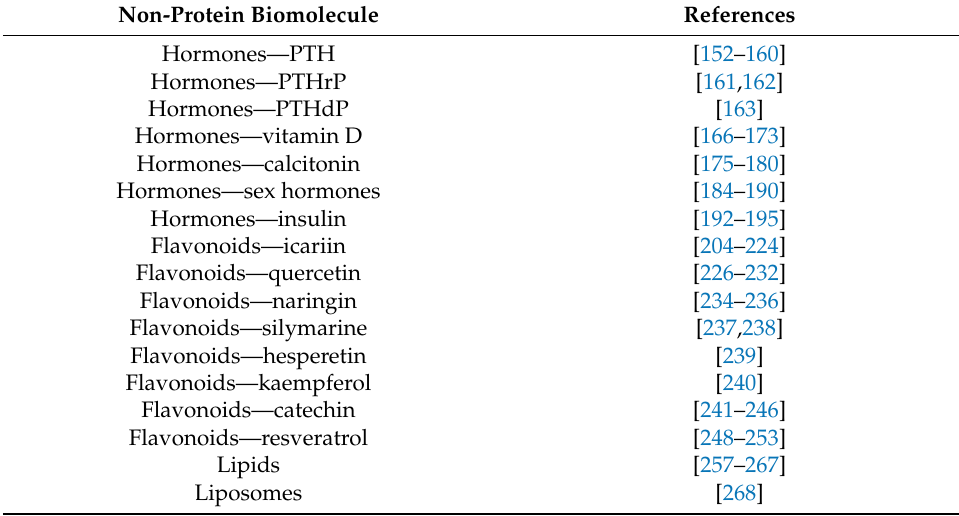
Table 2. Summary of the discussed non-protein biomolecule references. Non-Protein